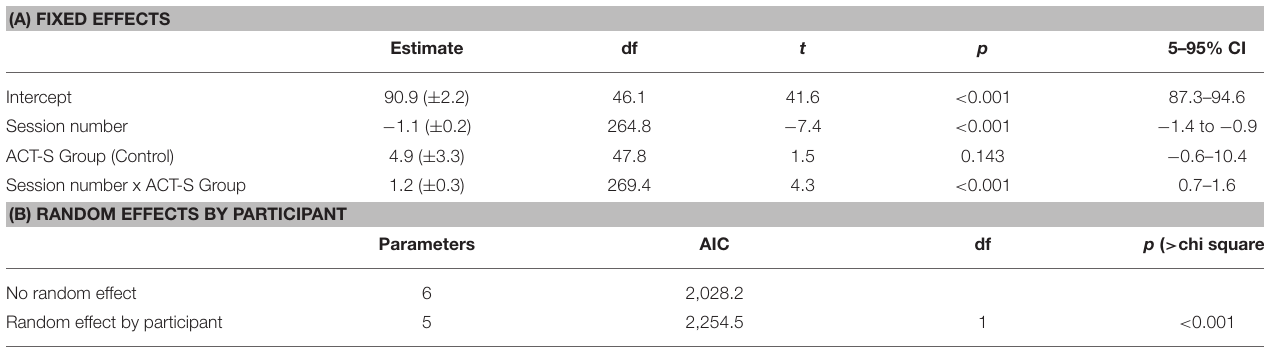
TABLE 4 | Change in heart